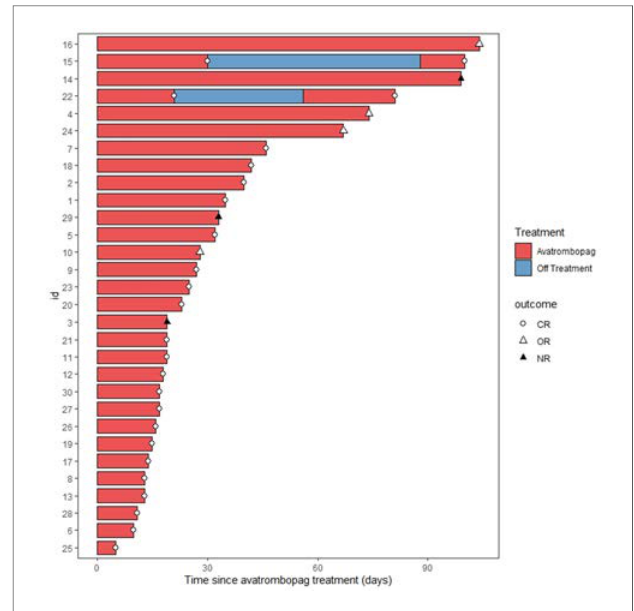
FIGURE 1 Swimmer plot for the response evaluation in all patients. CR, complete remission; OR, overall response; NR, no